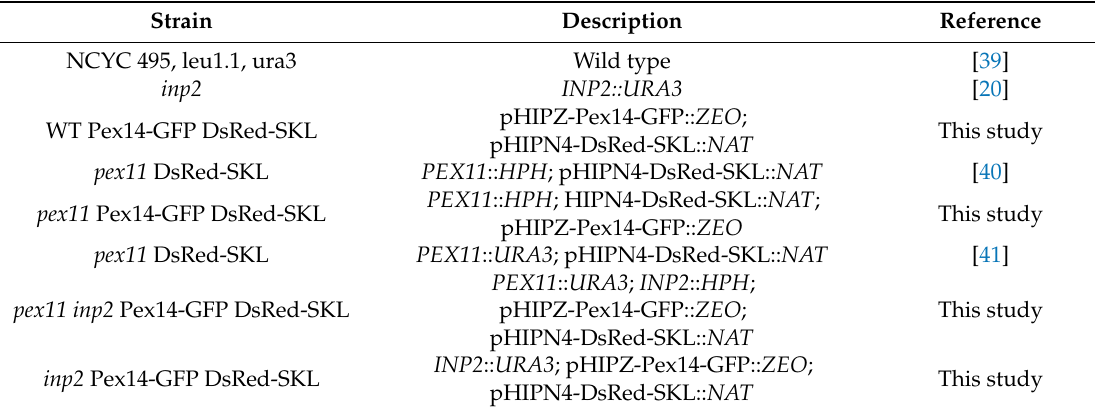
Table 1. H. polymorpha strains used in this